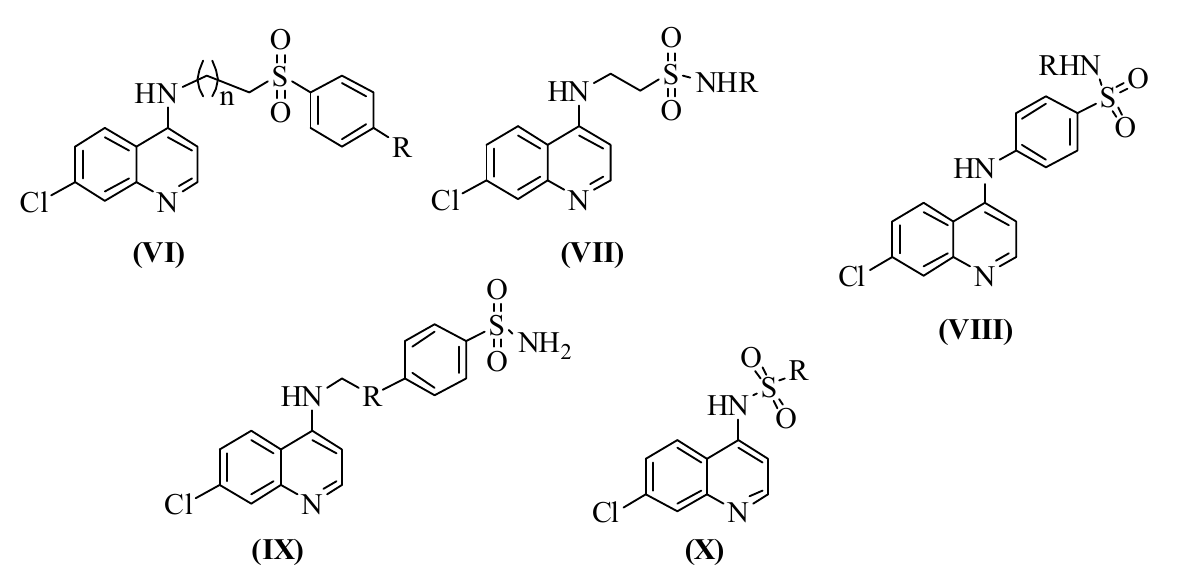
Figure 2. Representative quinoline–sulfonamide molecular hybrids VI – X .